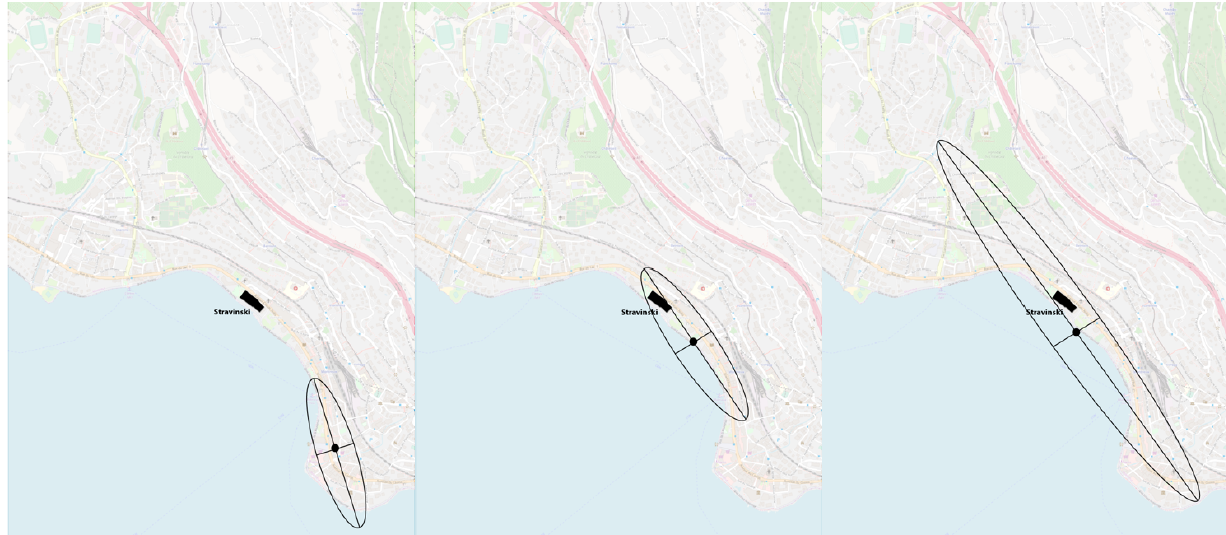
Figure 5. Centro-graphic analysis of the evolution of Festival sites (spread). Note: From left to right: 1990, 2000, and